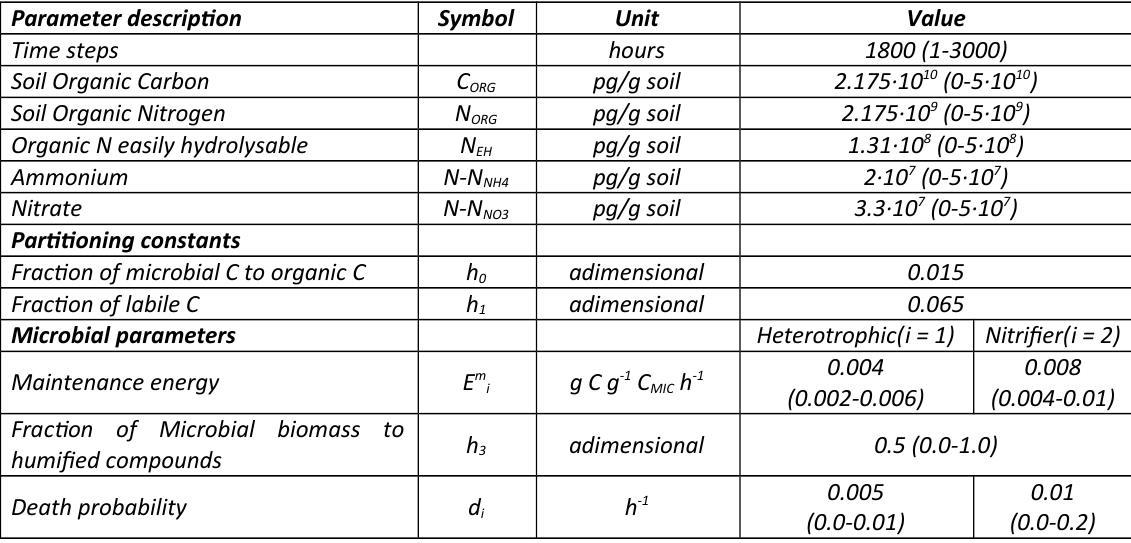
Table 1. Default values for running the simulatons, and the range of values in which they may be run (in